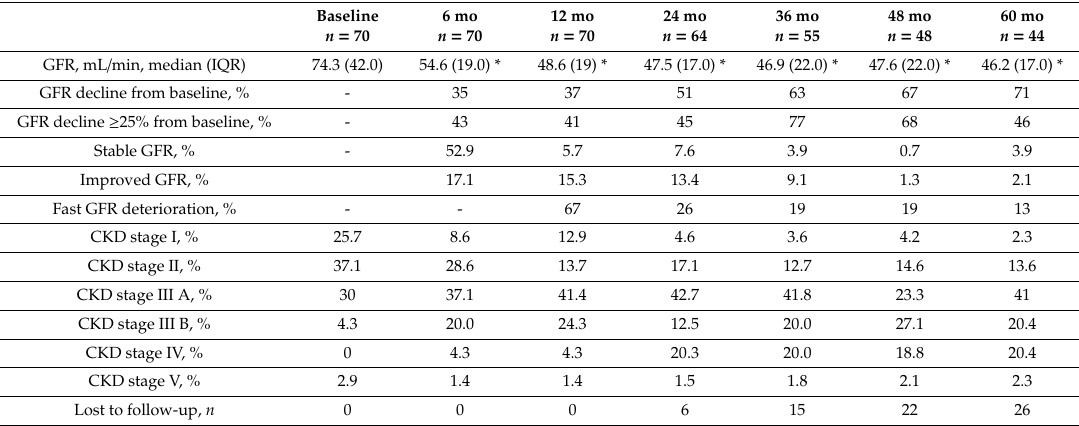
Table 2. Preoperative and follow-up renal function in the whole cohort.